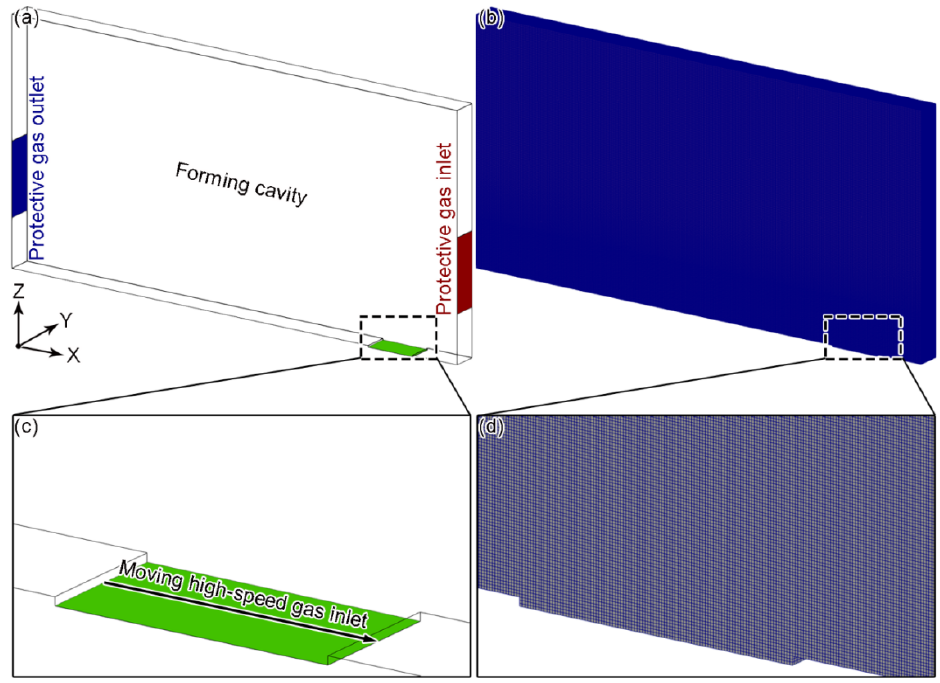
Figure 2. Geometry and mesh models: ( a ) geometry model; ( b ) mesh model; ( c ) partial enlargement of the geometry model; ( d ) partial enlargement of the mesh model. Table 1. Adopted conservation equations, boundary conditions, and initial conditions.